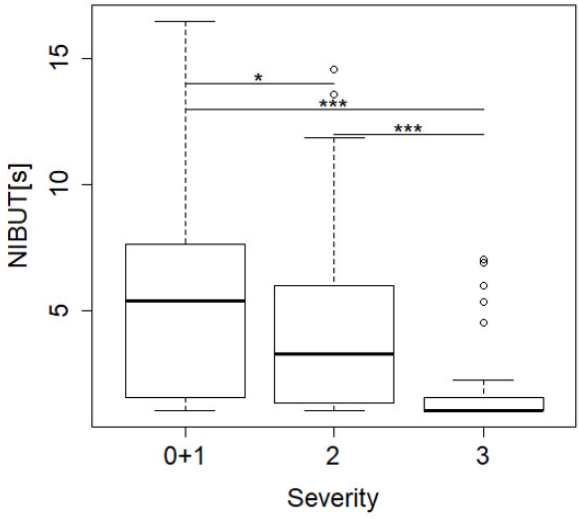
Figure 5. Association between software detected NIBUT with categorical clinical severity using DEWSII criteria. Levels 0 + 1 were combined. Steel–Dwass test *** p < 0.001, * p < 0.05 .